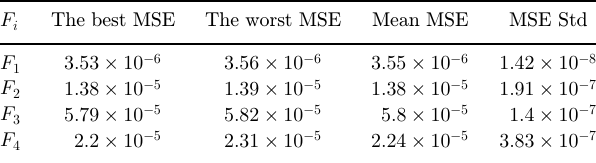
Table 3. The testing performance of 10 trials in